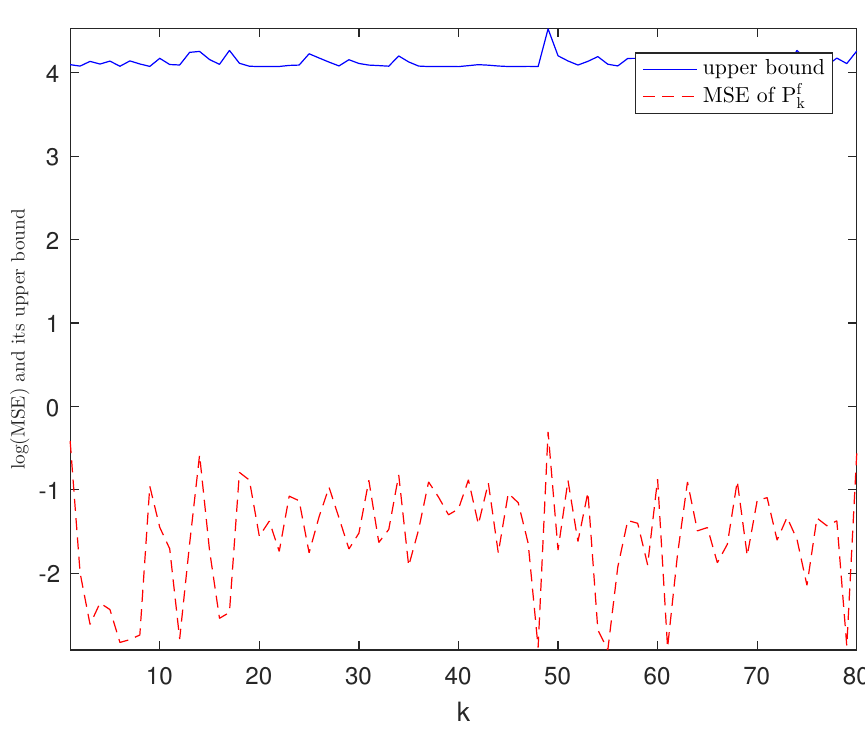
Figure 5. Log(MSE f k ) of f k and the trace of its upper bound.